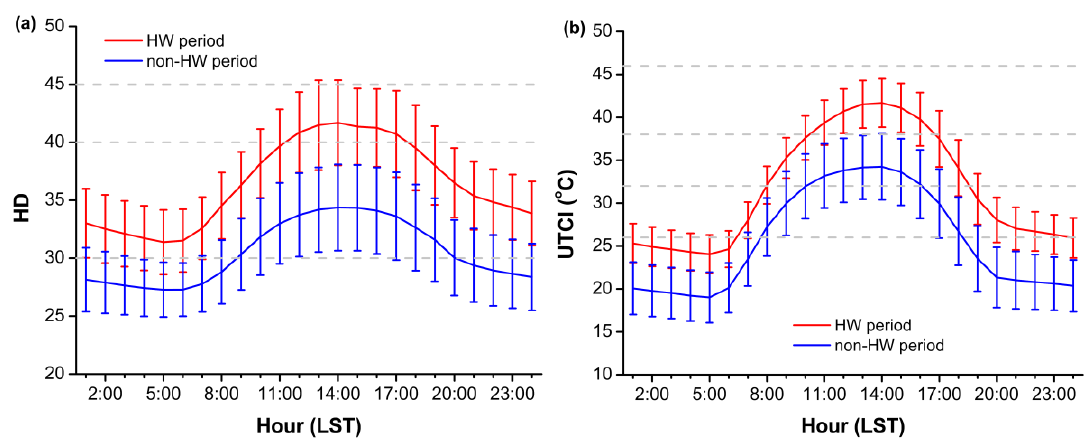
Figure 5. Averaged diurnal variation of ( a ) HD; ( b ) UTCI over the HW period and the non-HW period. The period of HWs refers exclusively to the 46 events of the 1960 – 2017 period, while the non-HW period refers to the reference period (1971 – 2000) without the detected HWs of that period. The horizontal dashed lines indicate the thresholds of each index as presented in Table 1 and Table 2.